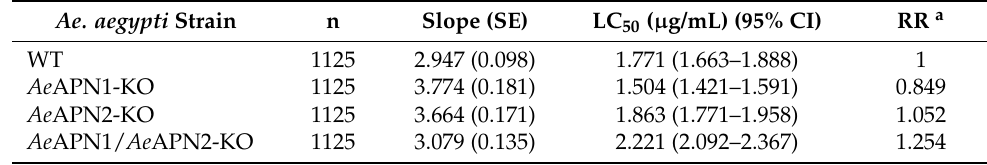
Table 3. Susceptibility of Ae. aegypti strains to Cry4Ba toxin.